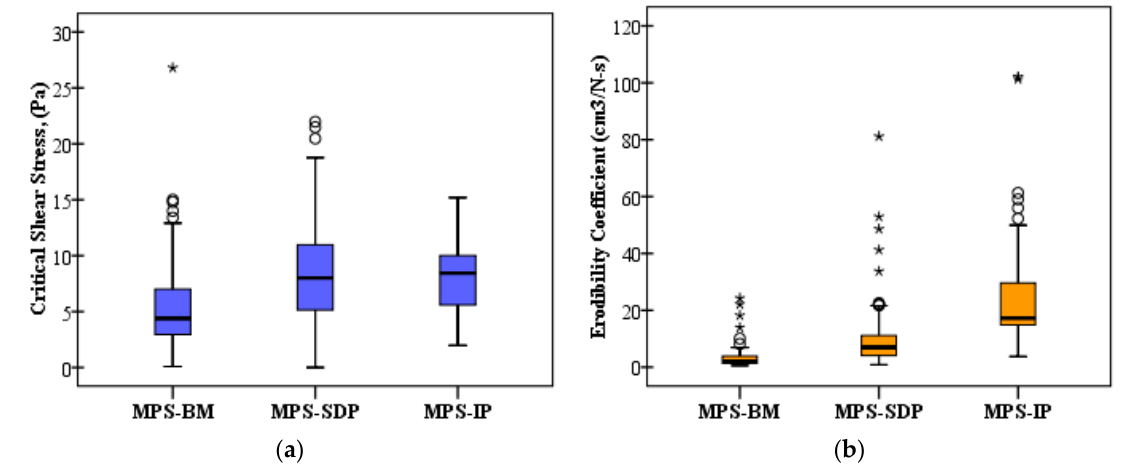
Figure 8. A comparison of ( a ) critical shear stress and ( b ) erodibility coefficient using the MPS method for the computational procedures: MPS-BM, MPS-SDP, and MPS-IP (as defined in Table